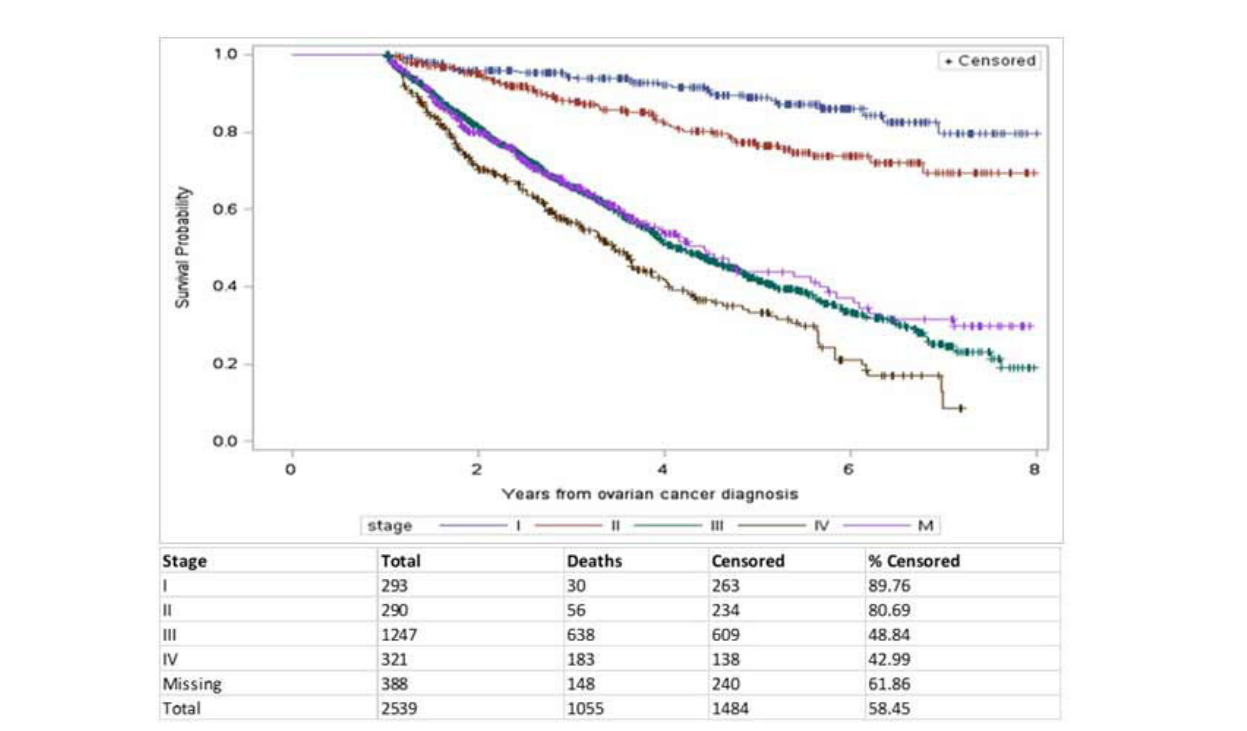
Figure 2. Kaplan Meier Curve of Overall Survival, Stratified by Stage of